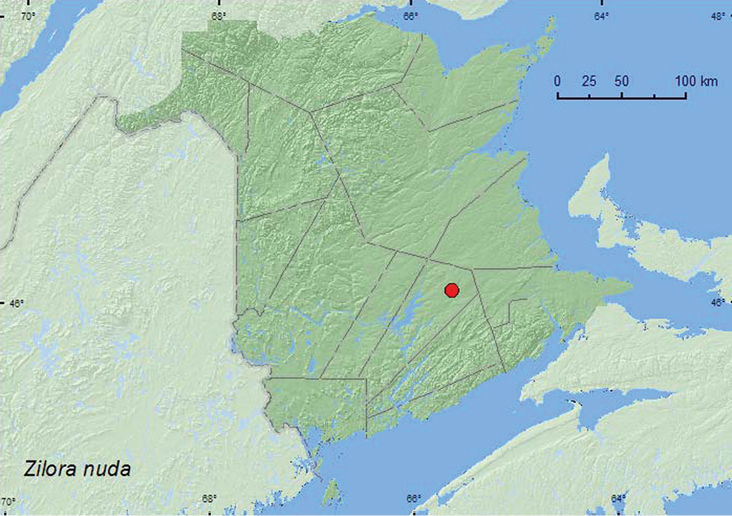
Collection localities in New Brunswick, Canada of Zilora nuda.